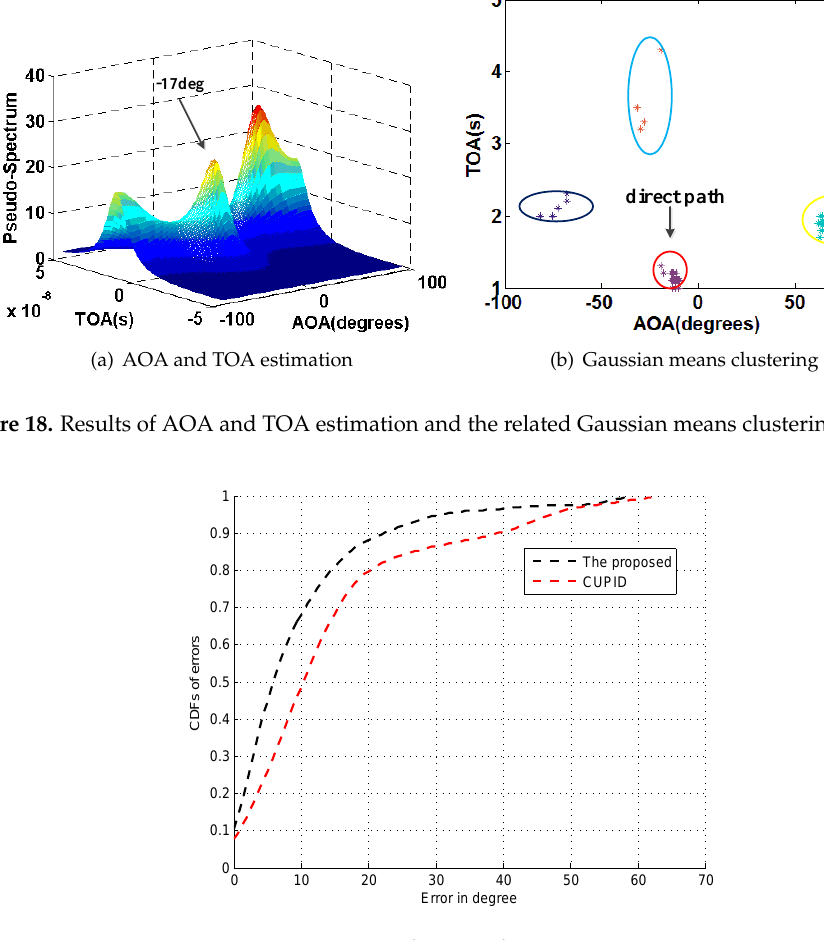
Figure 19. CDFs of errors of AOA